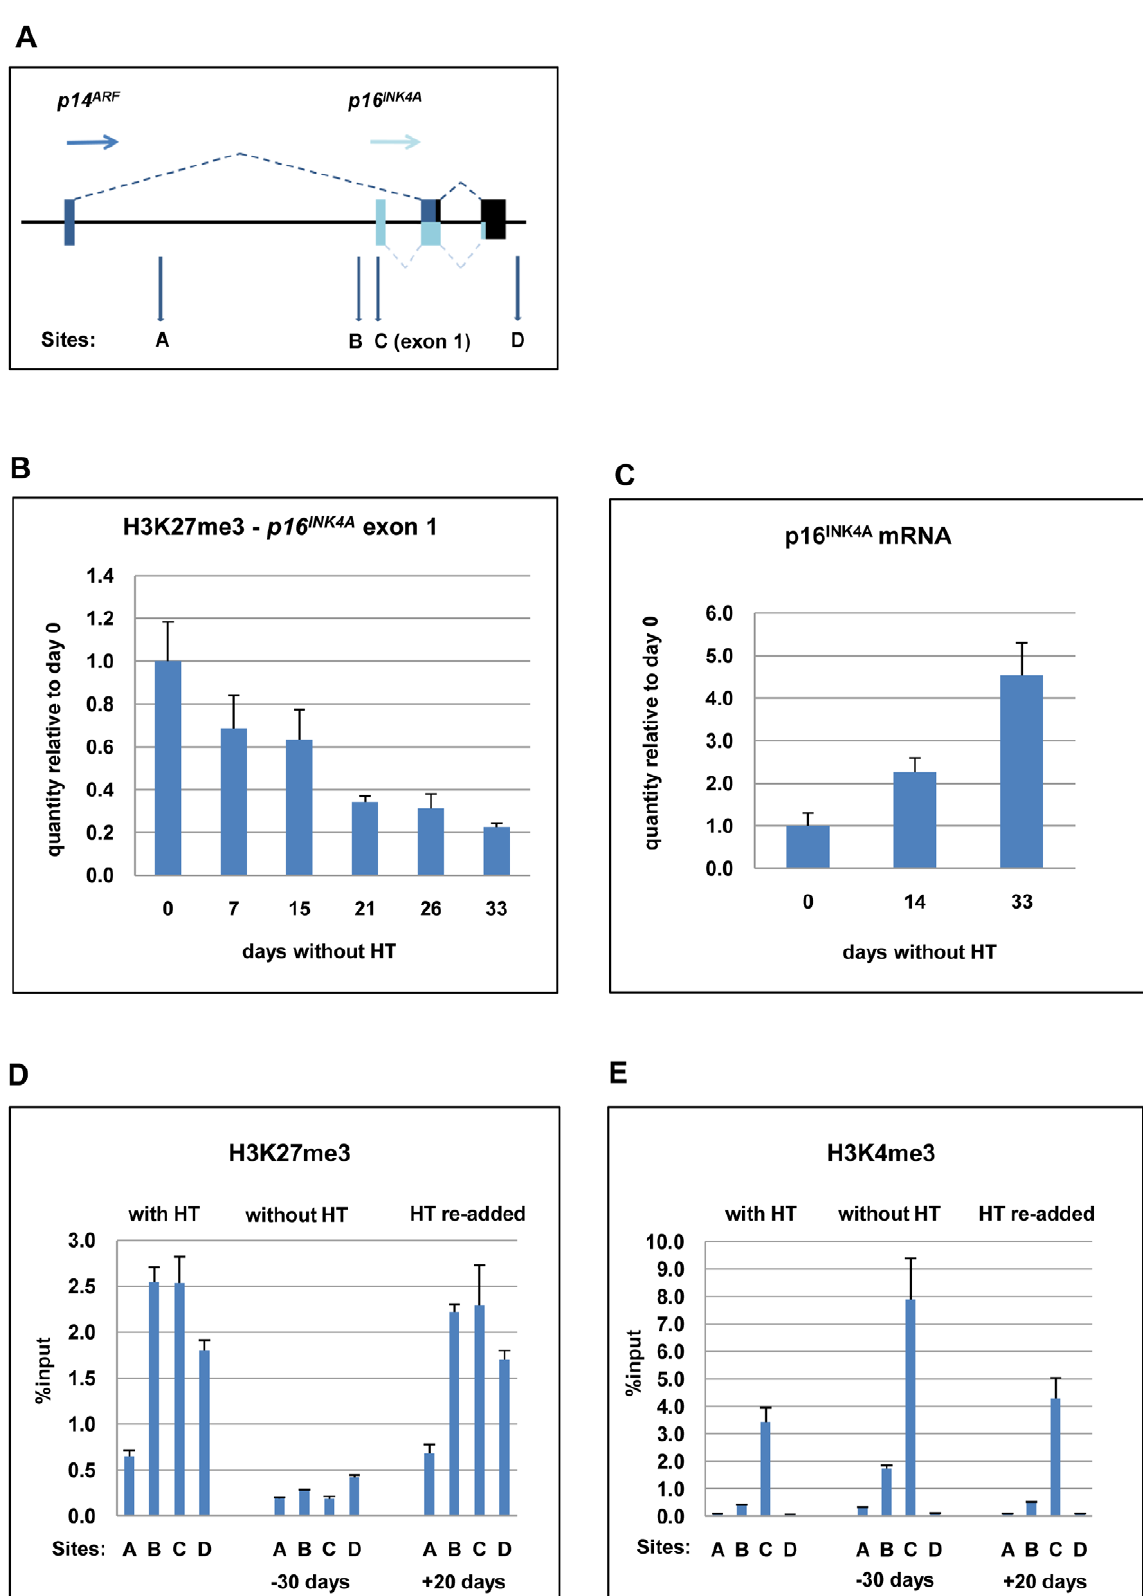
Figure 5. ChIP analysis to quantify the H3K27me3 and H3K4me3 marks on p16 INK4A exon 1 when EBNA3C is inactivated and re- activated in LCL 3CHT. ( A ) Schematic of the human p16 INK4A -ARF locus showing the location of coding exons (boxes) and transcription start sites (horizontal arrows) – not drawn to scale. The vertical (A-D) arrows refer to the approximate locations of primer pairs used for qPCR analysis of